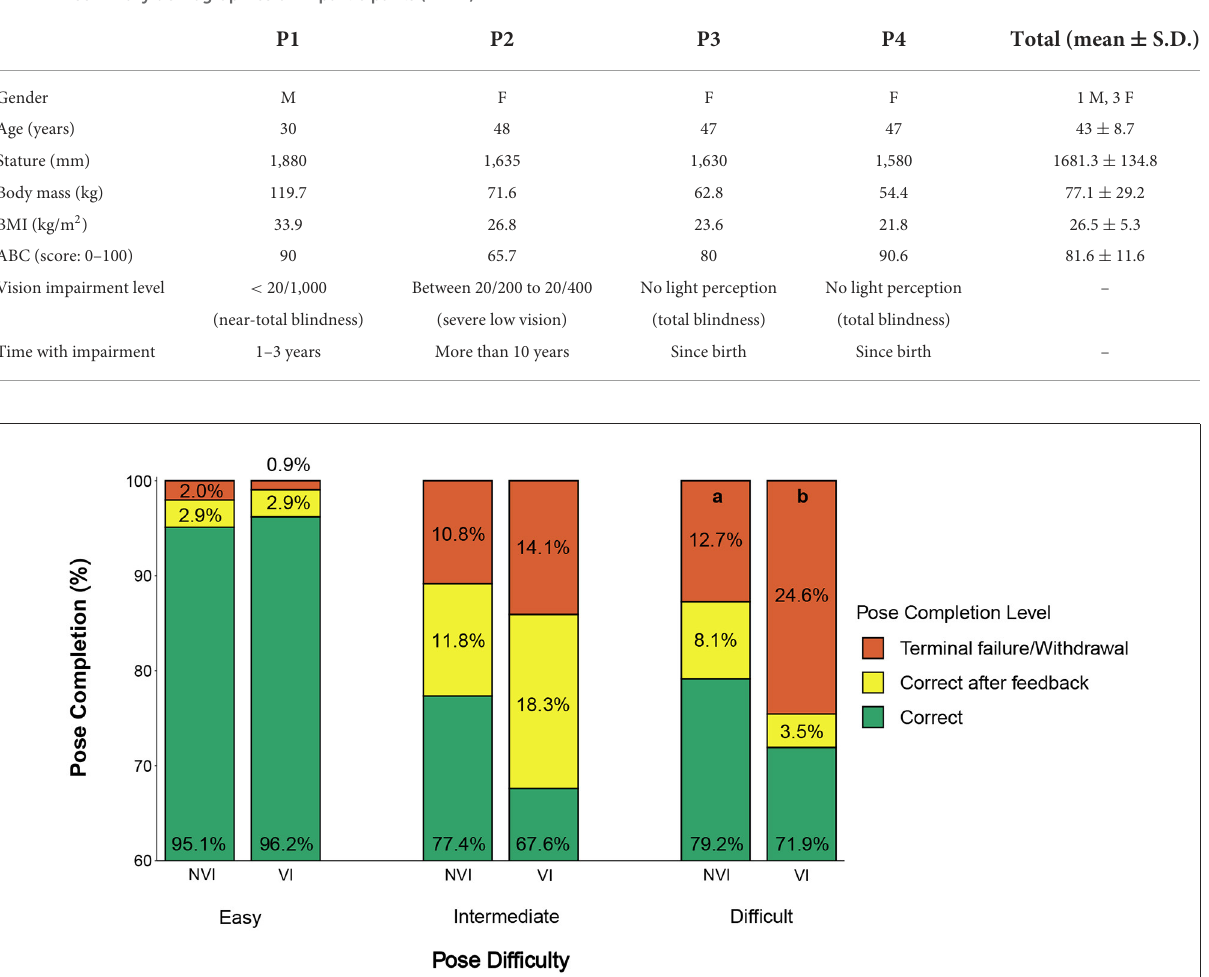
FIGURE10 Comparison of pose completion rates (%) for NVI and VI participants. Letters indicate significant pairwise differences between NVI and VI within the same category at p <